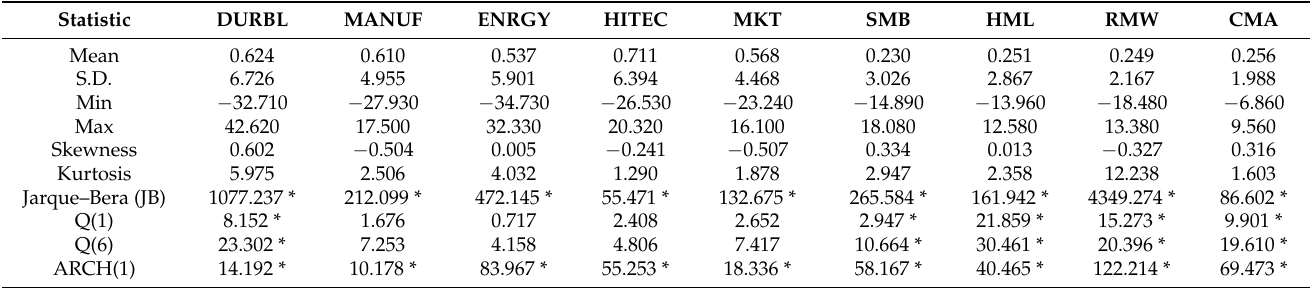
Table 1. Descriptive statistics.